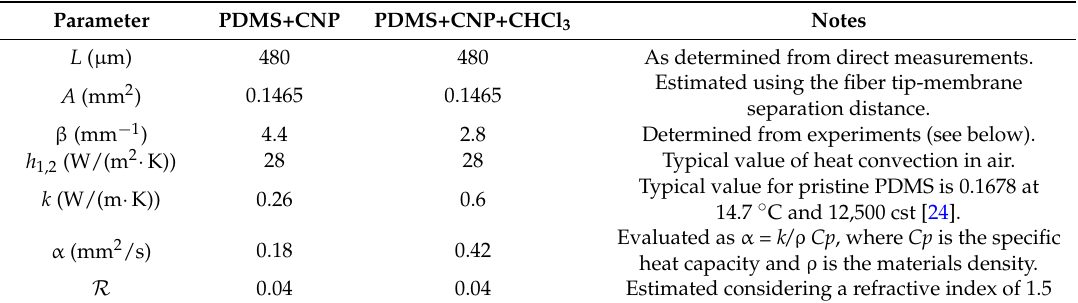
Table 1. Parameters used in Equation (8) to fit the experimental data shown in Figure